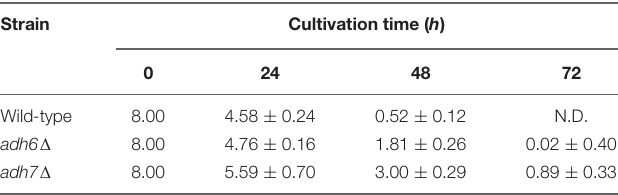
TABLE 3 | Changes in vanillin concentrations (mM) in the culture medium during cultivation for 72 h. Strain Cultivation time ( h